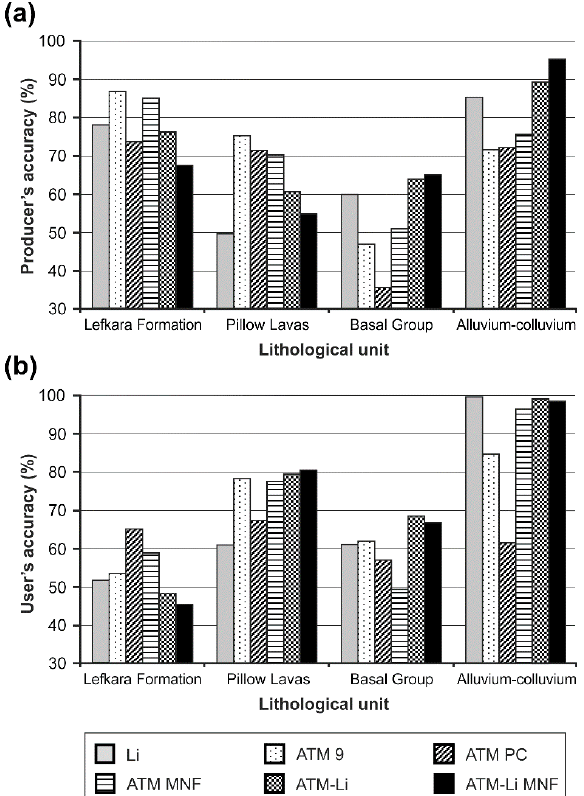
Figure 6. Individual lithological class accuracies of maps generated using the OBIA approach: ( a ) Producer’s accuracy (PA); and ( b ) User’s accuracy (UA).